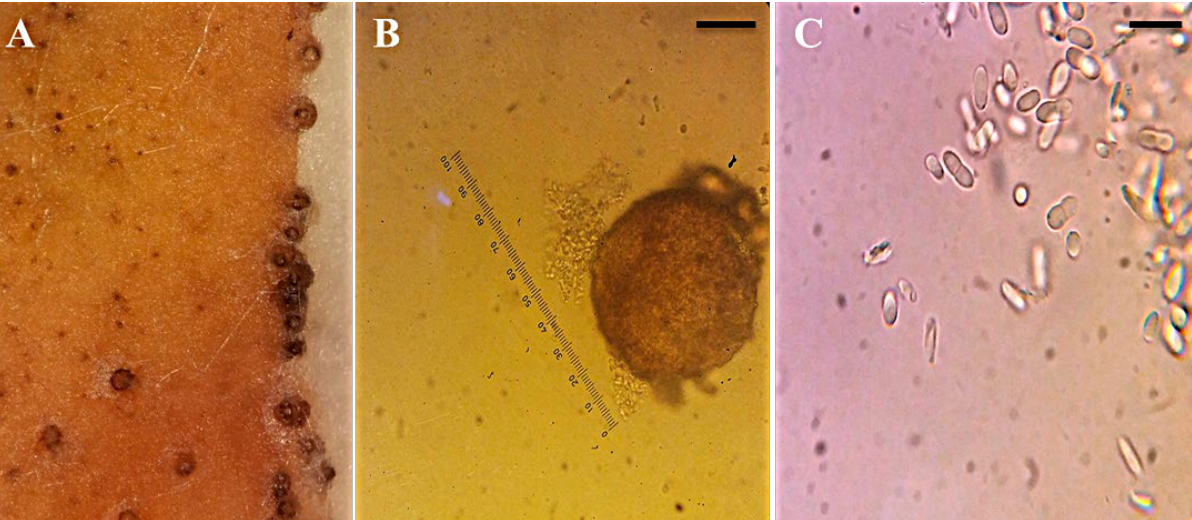
Figure 2. Morphological characteristics of Stagonosporopsis cucurbitacearum . A, Row of pycnidia on peel from a squash fruit under the ster- eomicroscope. B, Pycnidia under the microscope. Scale bar = 50 μm. C, Aseptate and one-septate pycnidiospores. Scale bar = 10